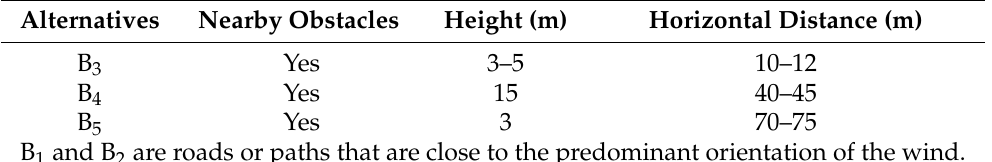
Table 4. Alternatives of the typology of free-standing turbines. Urban indicators.